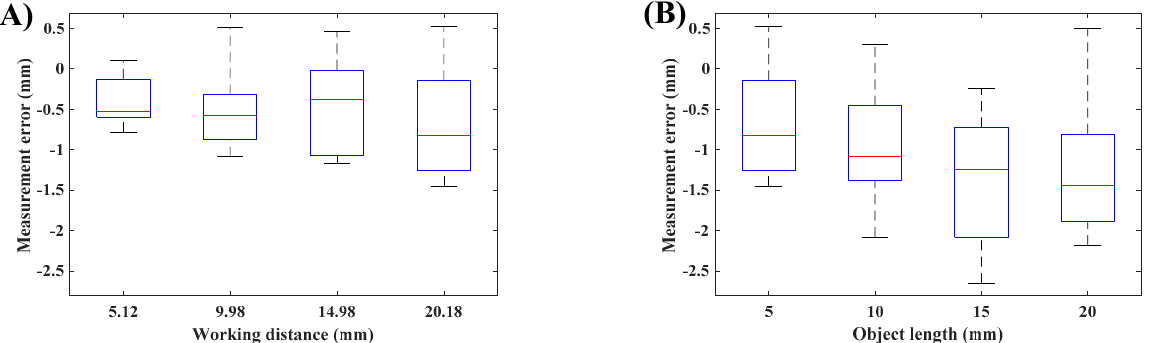
Figure 12 . Performance of uniform model for general measurements: ( A ) effect of working distance, and ( B ) effect of object length.